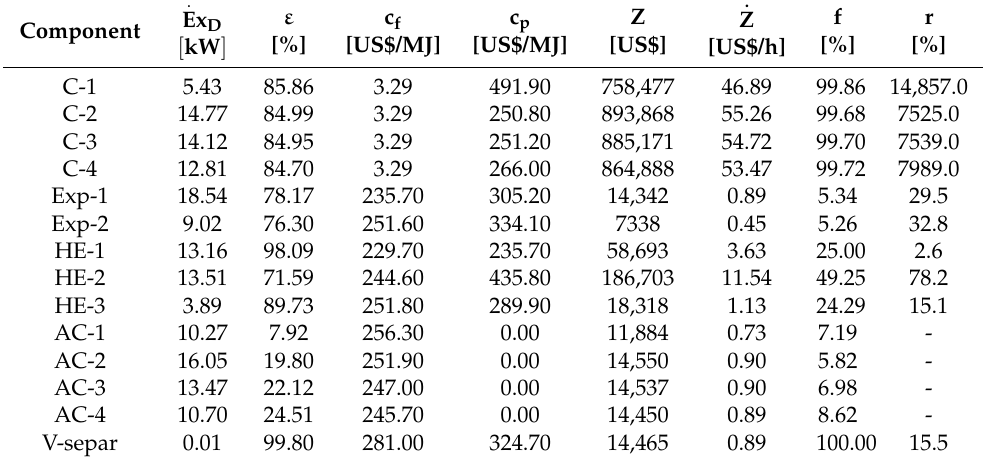
Table 6. Exergy and exergoeconomic